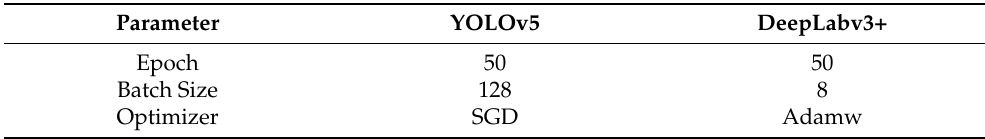
Table 5. Parameter settings for data